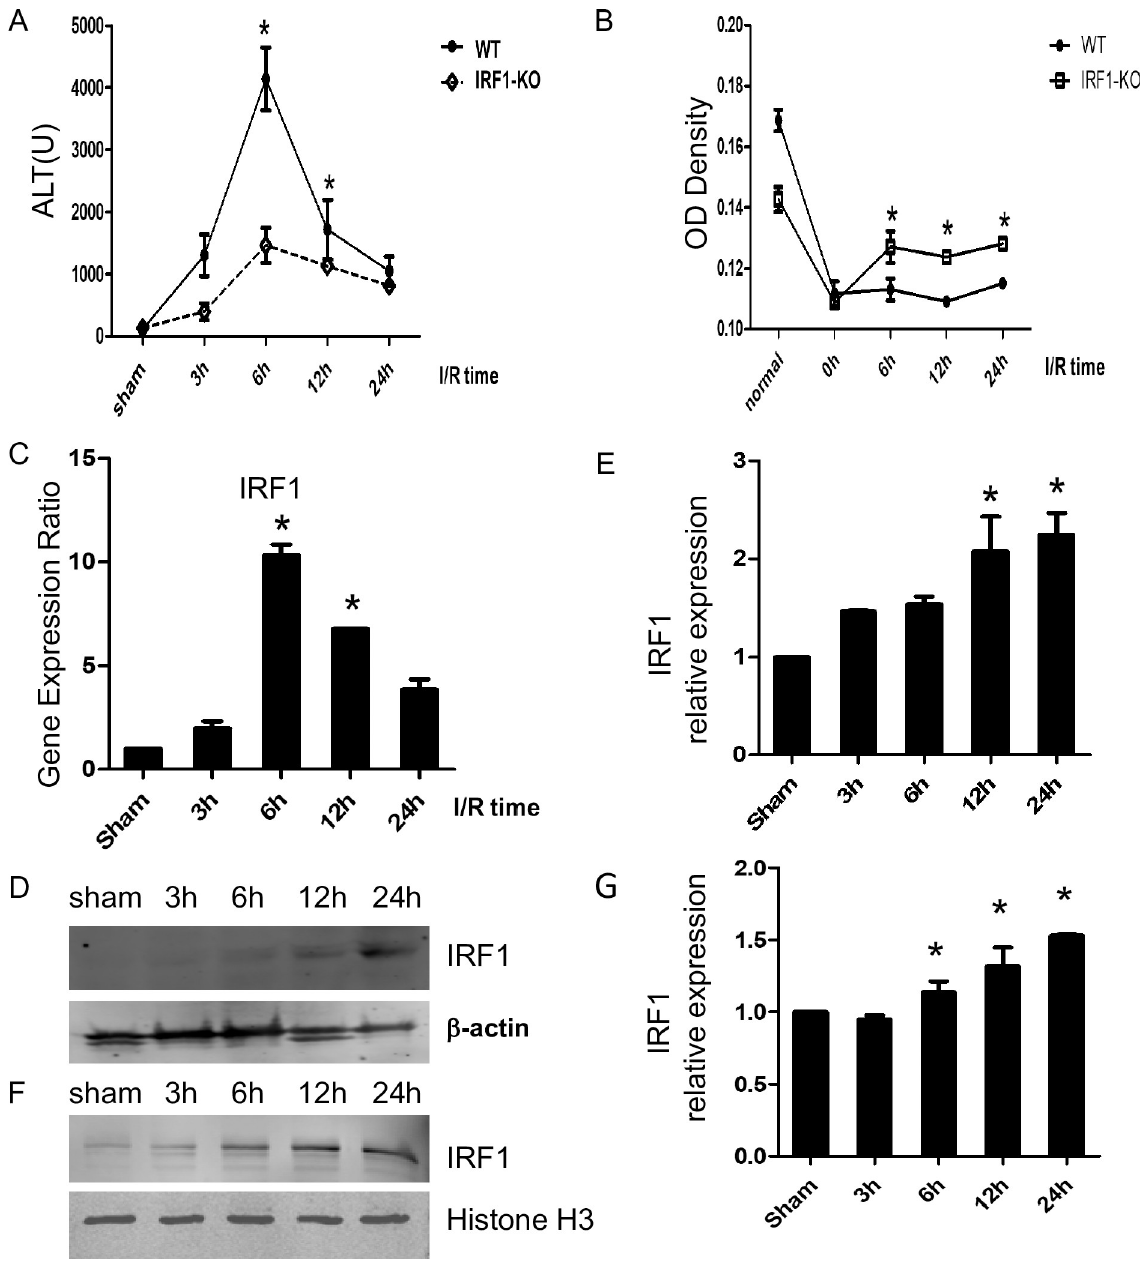
Fig 1. IRF1 up-regulation do harm for hepatocytes in warm IR. A) The serum ALT levels were significantly increased in WT mice after exposure to IR as compared with the IRF1-KO mice(n = 6). B) The cell growth was detected by CCK-8 assay in hypoxia reoxygenation treatment. C) IRF1 gene expression increased during IR. D and E) IRF1 cytoplasmic (D and E) and nuclear (F and G) protein expression was tested by Western Blot and densitometric analysis(n = 3). Data are presented as mean ± SD, � P < 0.05 vs. the sham